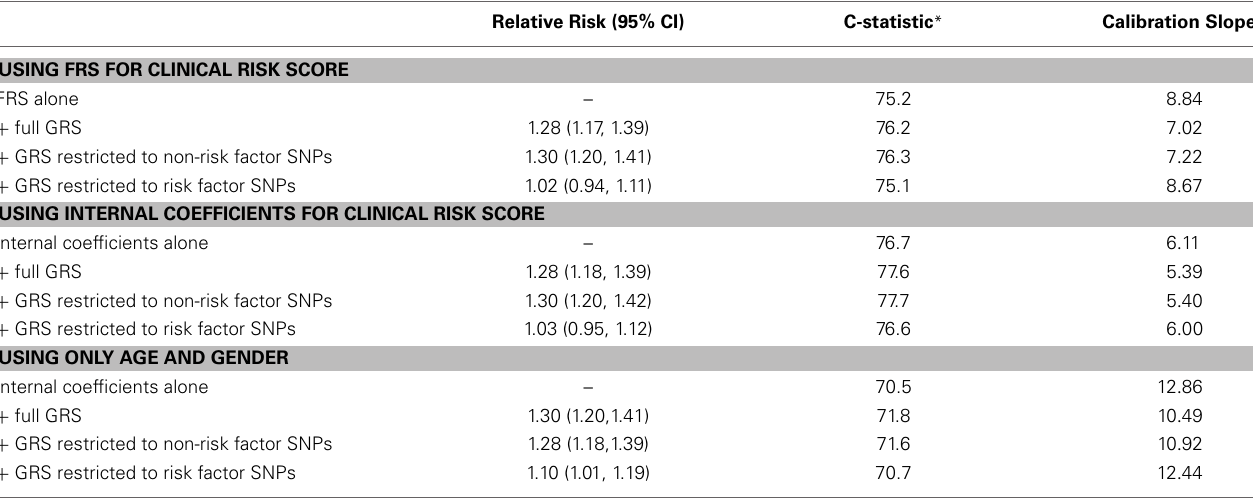
Table 3 | Relative Risks and discrimination metrics for a genetic risk score derived from 50 genome wide significant susceptibility alleles for CHD in the ARIC subset of white/Europeans with no diabetes at baseline ( n = 7865).